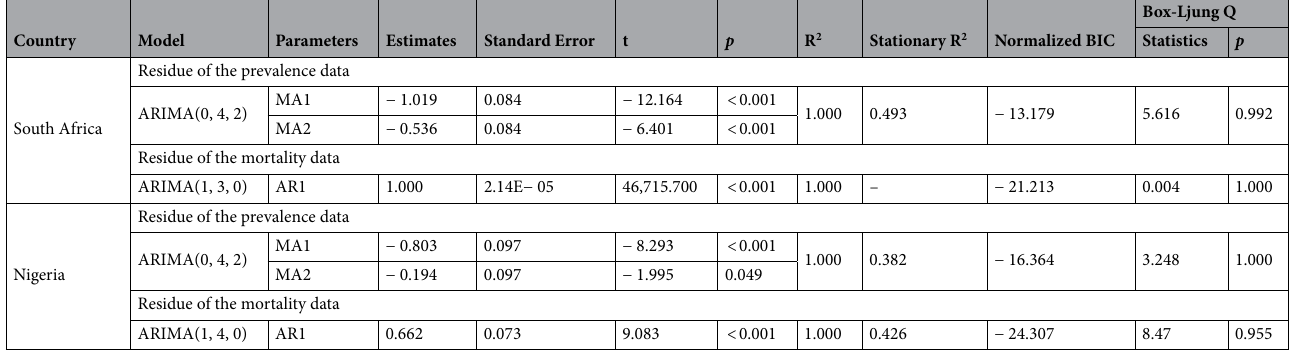
Table 5. The identified parameters of the best-fitting ARIMA models for the decomposed residue of the COVID-19 the prevalence and mortality in South Africa and Nigeria. ARIMA Autoregressive integrated